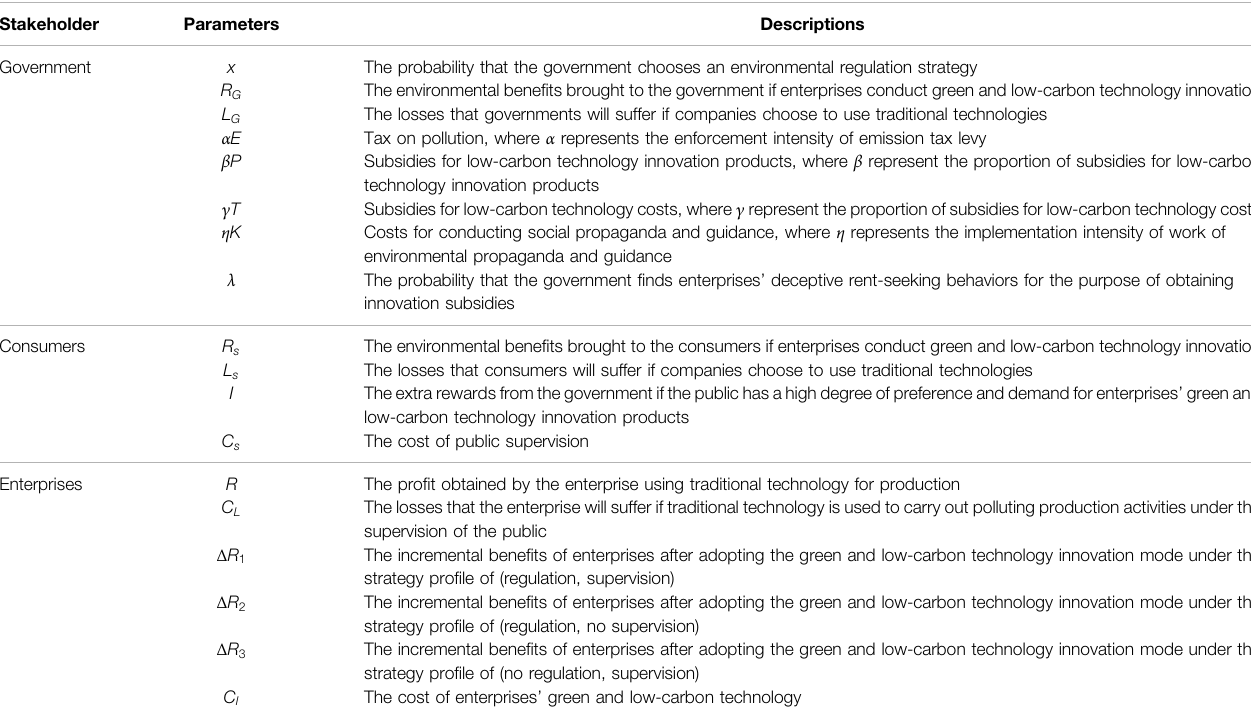
TABLE 1 | Parameter descriptions.